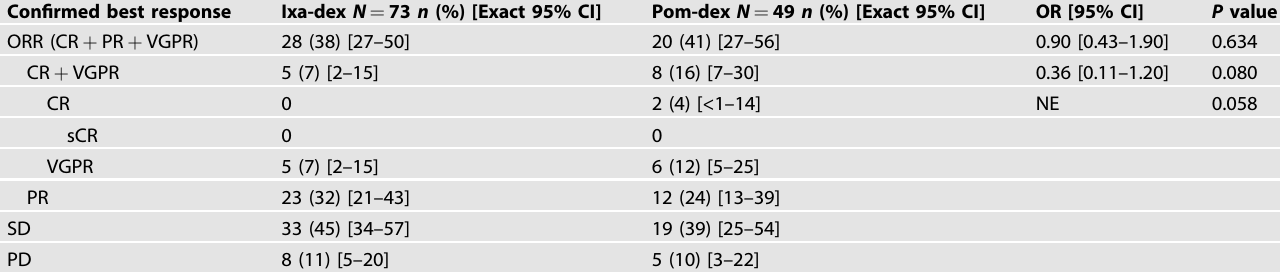
Table 2. Best con fi rmed responses to ixa-dex and pom-dex in the ITT population.